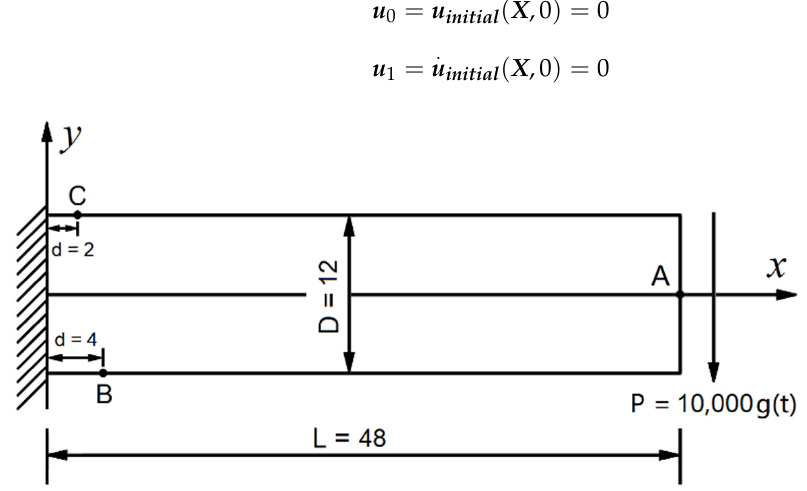
Figure 11. A cantilever beam subjected to a vertical traction.